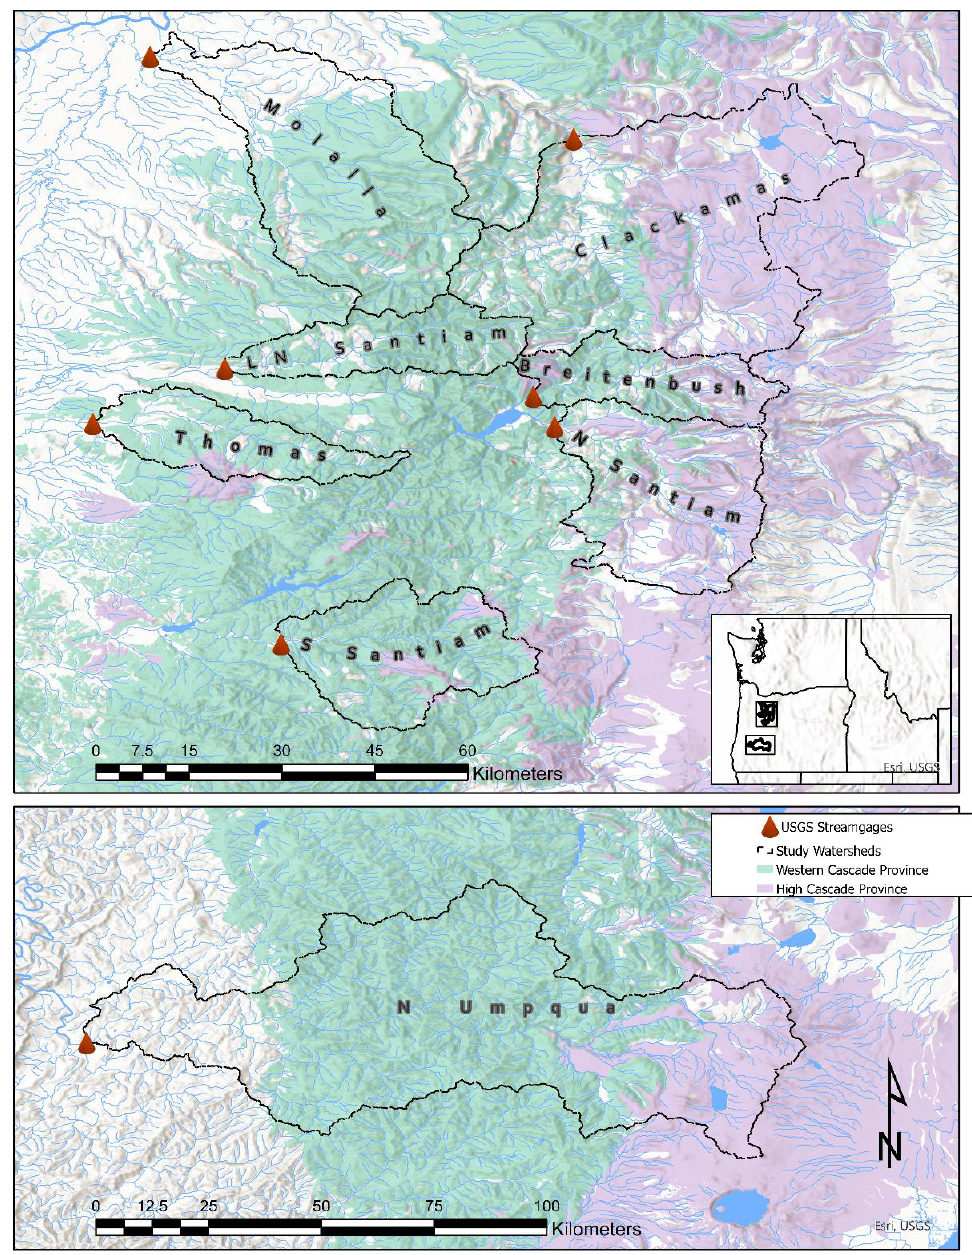
Figure 1. Surface geology of the study area displaying rocks of the Western Cascade Province and the High Cascade Province.